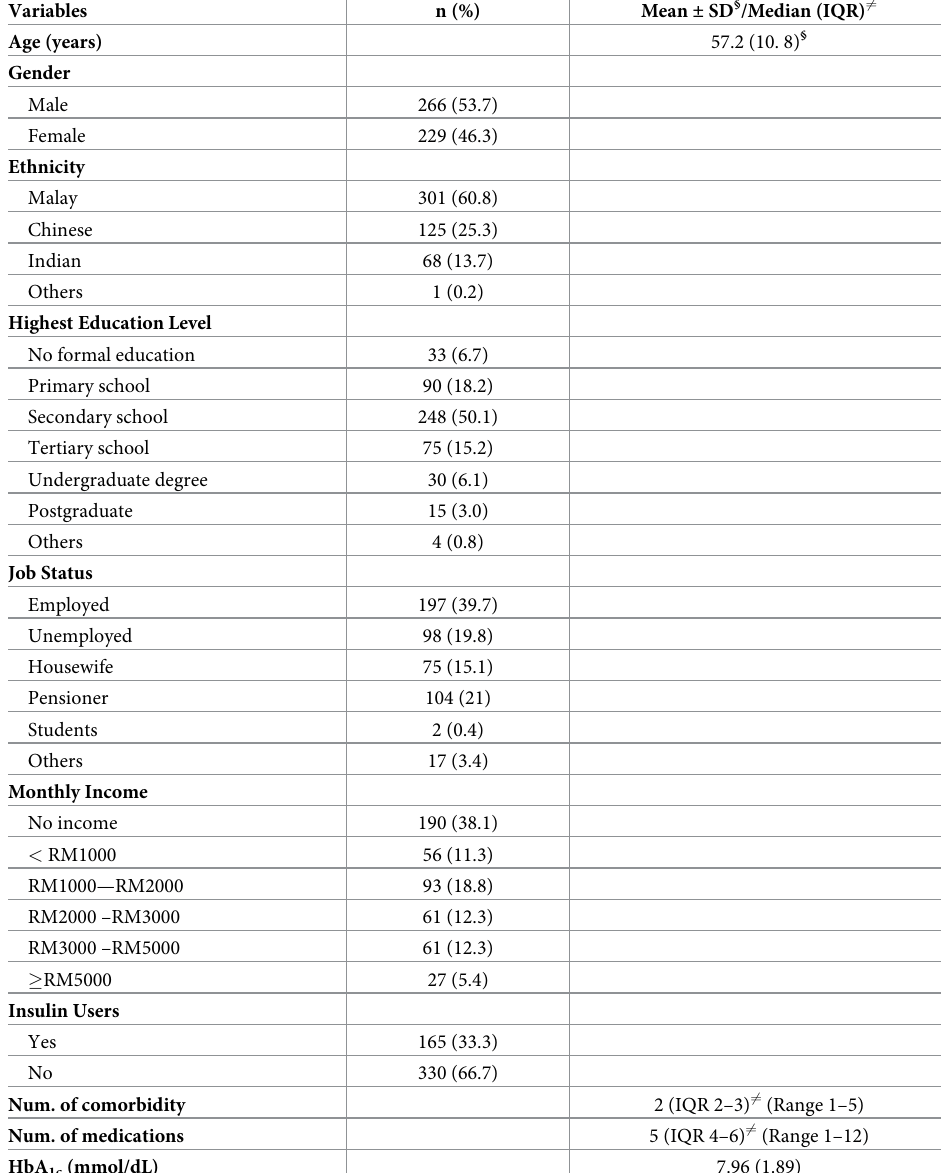
Table 2. Respondents’ demographic and characteristic (n =